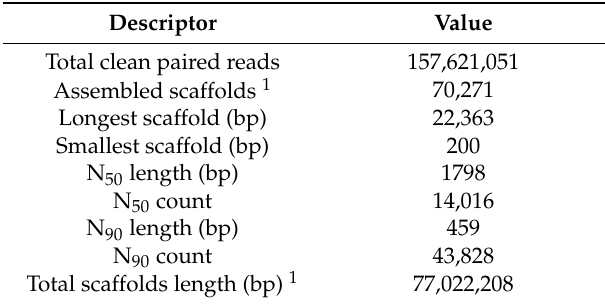
Table 2. Transcriptome de novo assembly statistical summary.